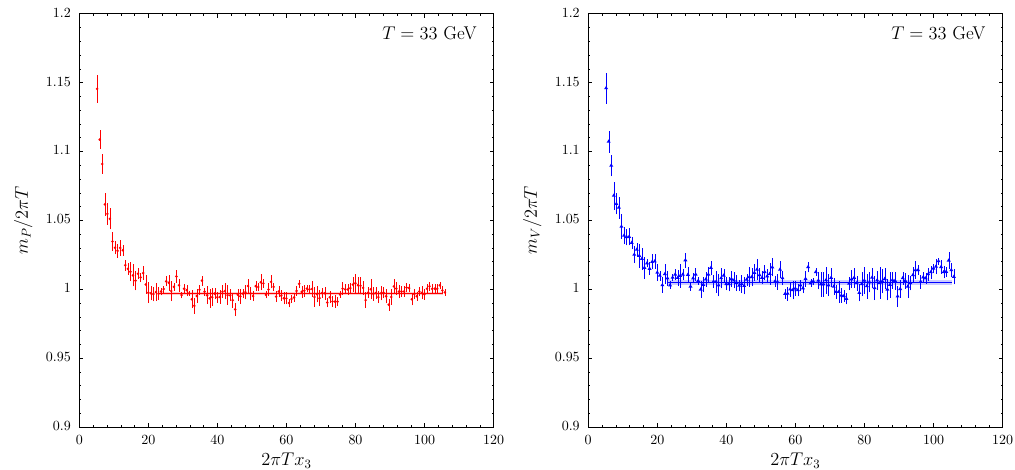
Figure 1 . Plot of the effective masses, normalized to 2 πT , for the pseudoscalar (left) and vector (right) correlators at the temperature T 3 for L 0 /a = 6